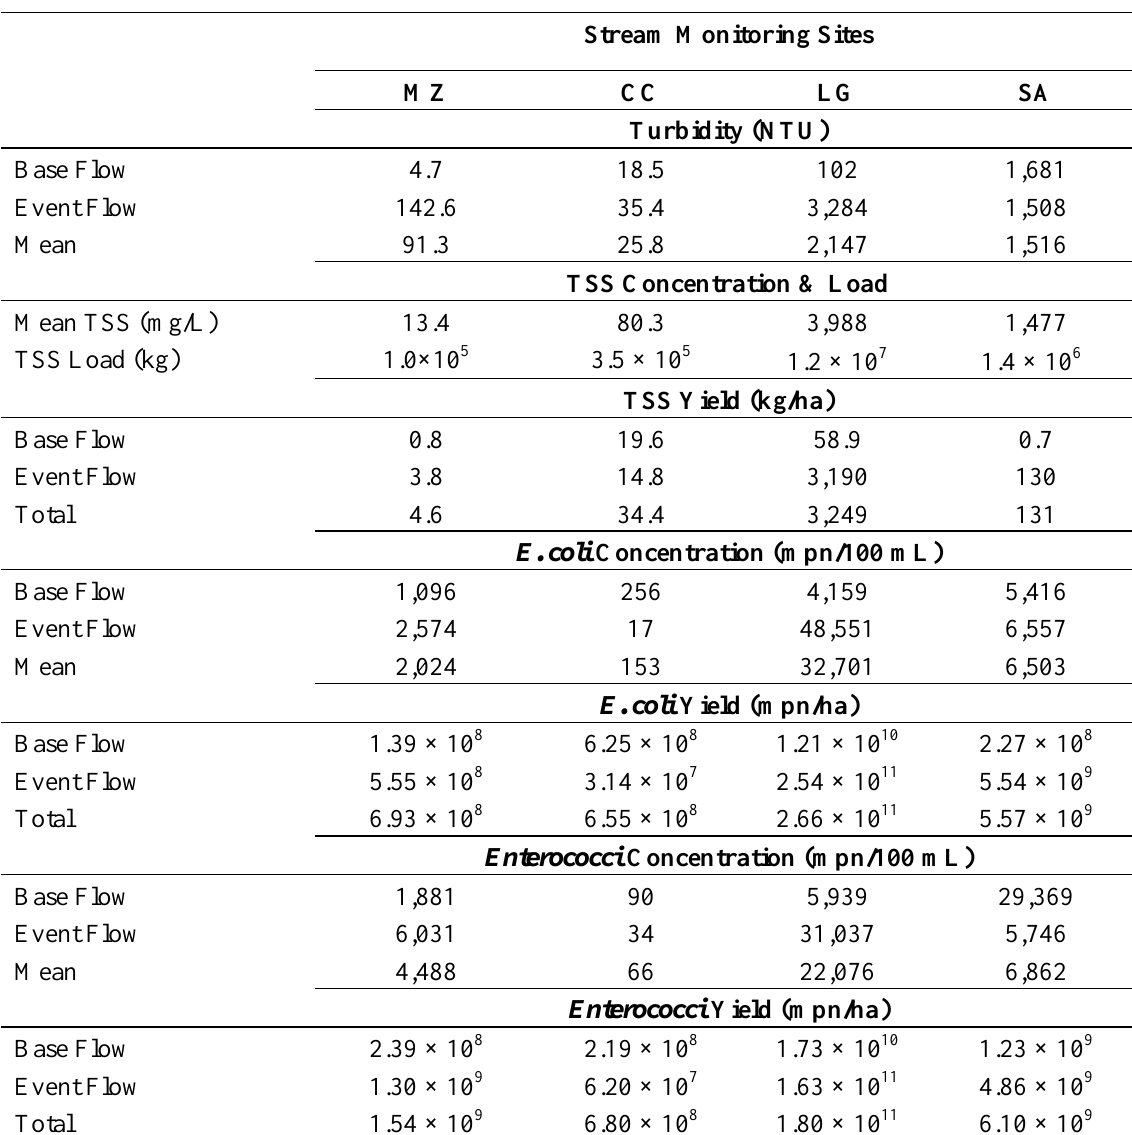
Table 2. Flow Weighted Turbidity (NTU), Total Suspended Solids (TSS) Concentration (mg/L), Load (kg), TSS Yield (kg/ha), E. coli & Enterococci Concentrations and Yield Results for Montezuma (MZ), Cow Creek (CC), Lower Gallinas (LG), and Spring Arroyo (SA) for 2003 & 2004, based on Daily Mean